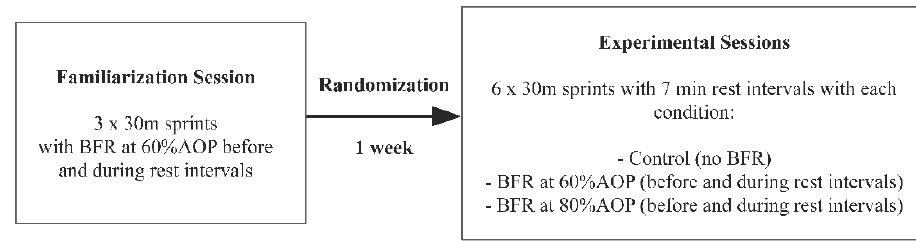
Figure 1. CONSORT flow